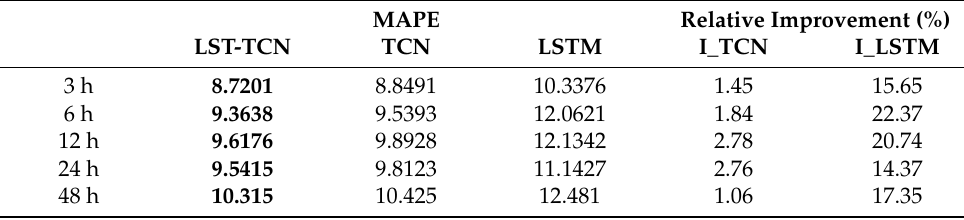
Table 3. MAPE error of each algorithm.